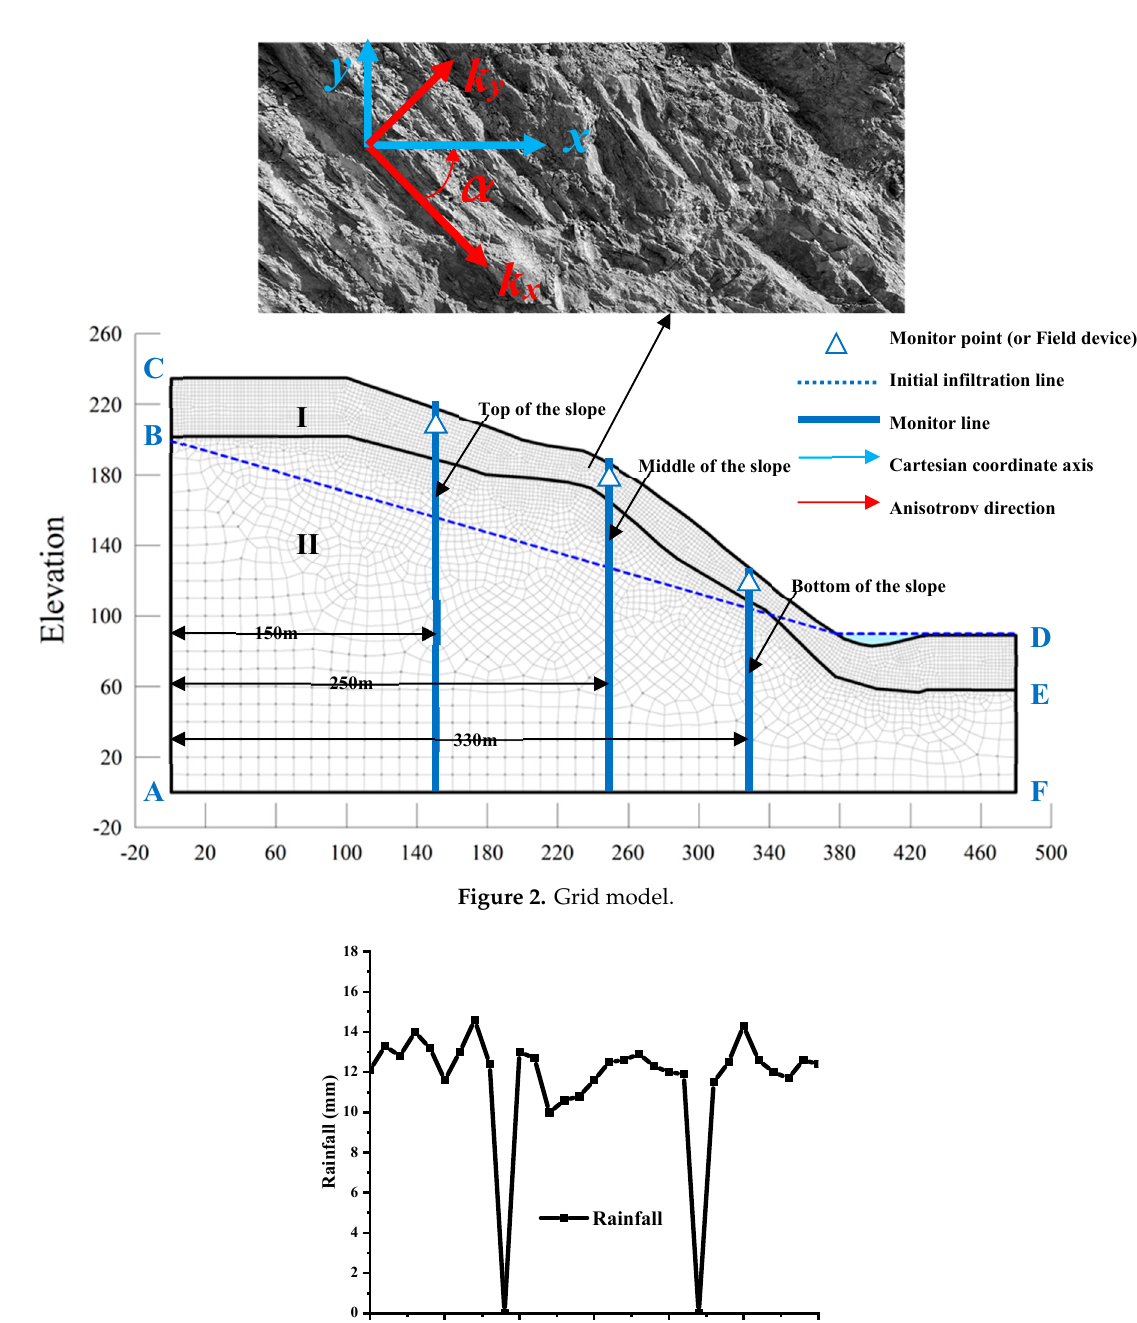
Figure 3. Daily rainfall from 1 July to 1August 2019.